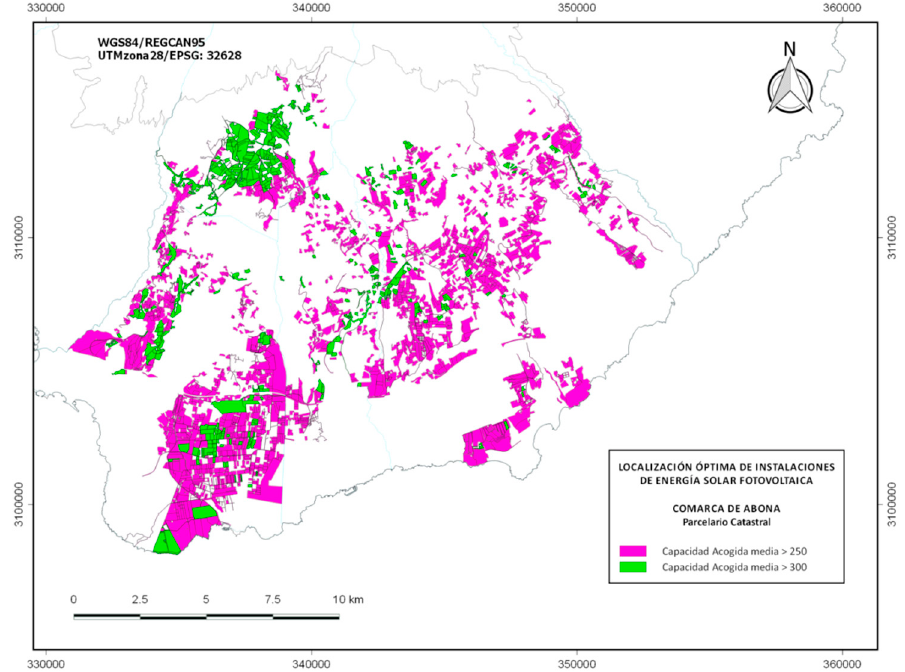
Figure 7. Plots with optimal locations in Abona region.